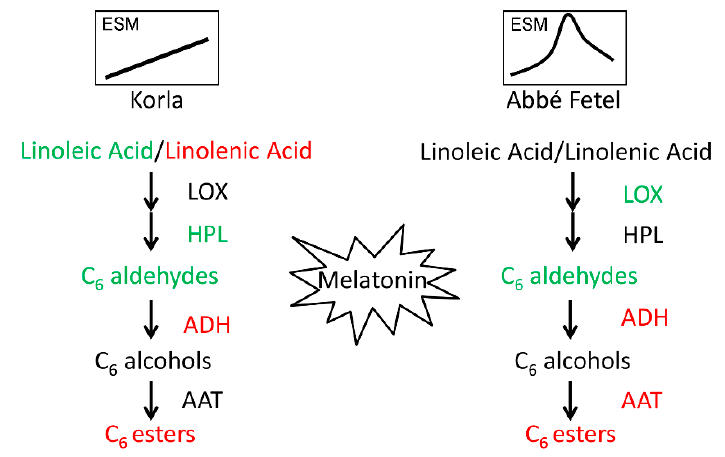
Figure 6. Model depicting the mechanism of the effect of melatonin on aroma in ‘Korla’ and ‘Abbé Fetel’. Red: upregulation; Green: downregulation. ESM: Synthesis model of ethylene in postharvest fruits.